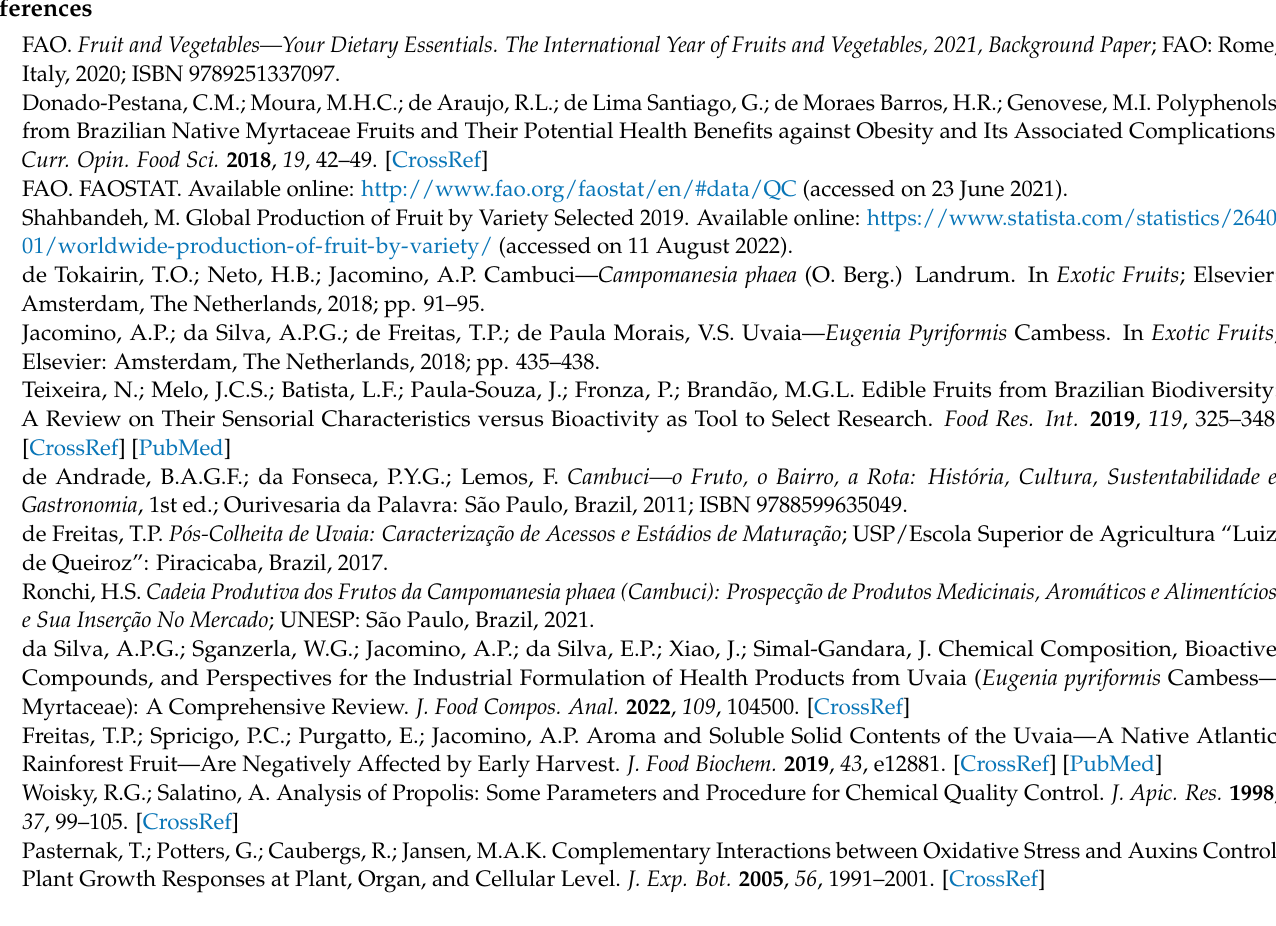
Table S3: Accessions and sampling municipalities of the 51 cambuci accessions investigated herein. Table S4: Accessions and sampling municipalities of the 71 uvaia accessions investigated herein. Reference [50] is cited in the supplementary